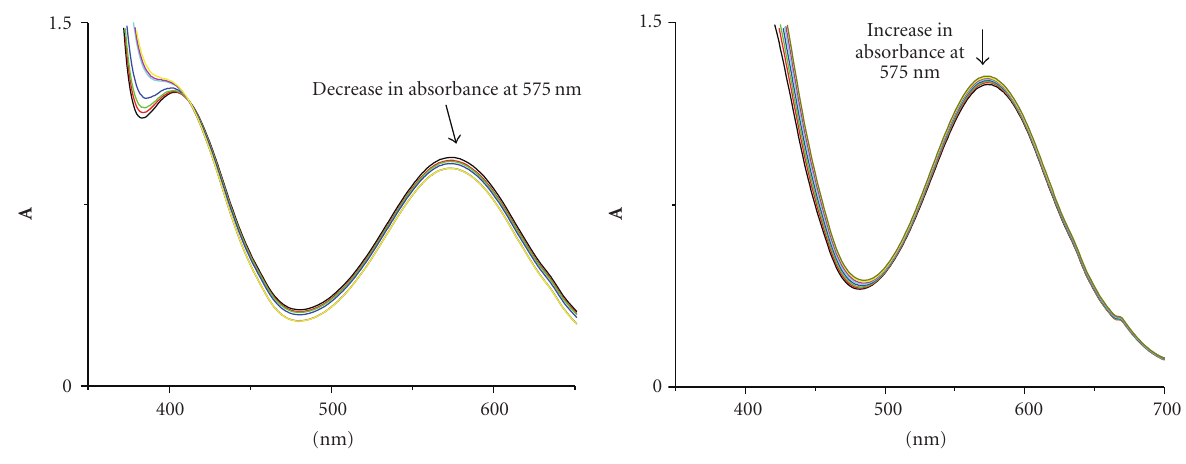
(a) Spectra recorded at various times after mixing: 13min, 23min,33min,63min, 134min,154min,184min